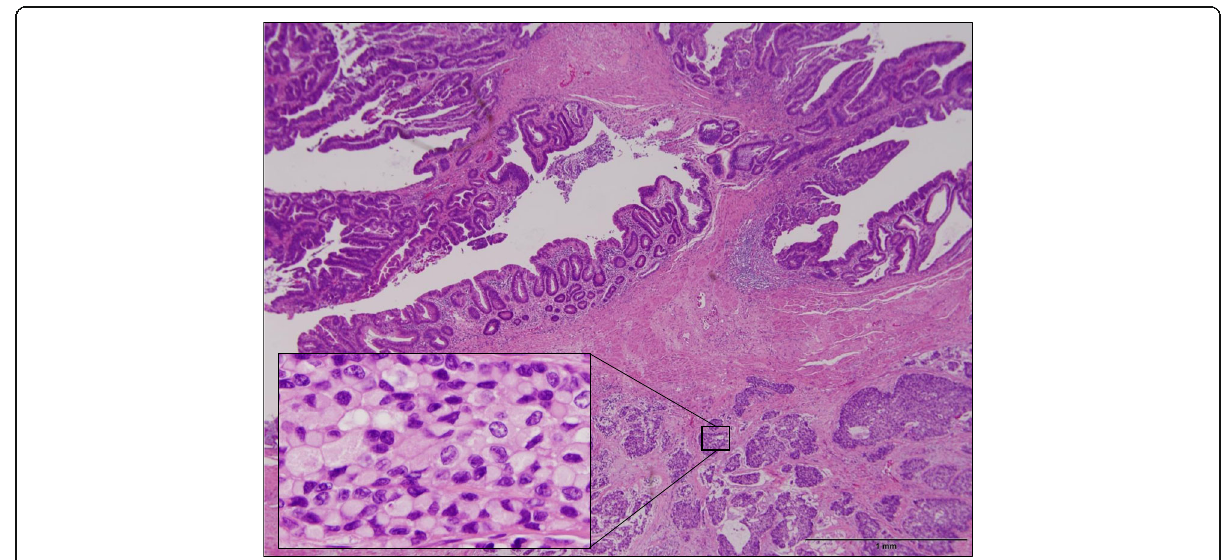
Fig. 5 Histopathologic evaluation showed a malignant neoplasm with goblet-like cells. Malignant cells with nests were found from the submucosa to the adventitia with lymphatic and venous invasion. Components of well-differentiated adenocarcinoma were also found in the mucosa (hematoxylin and eosin ×10, a small window shows a magnified image of goblet-like cell components